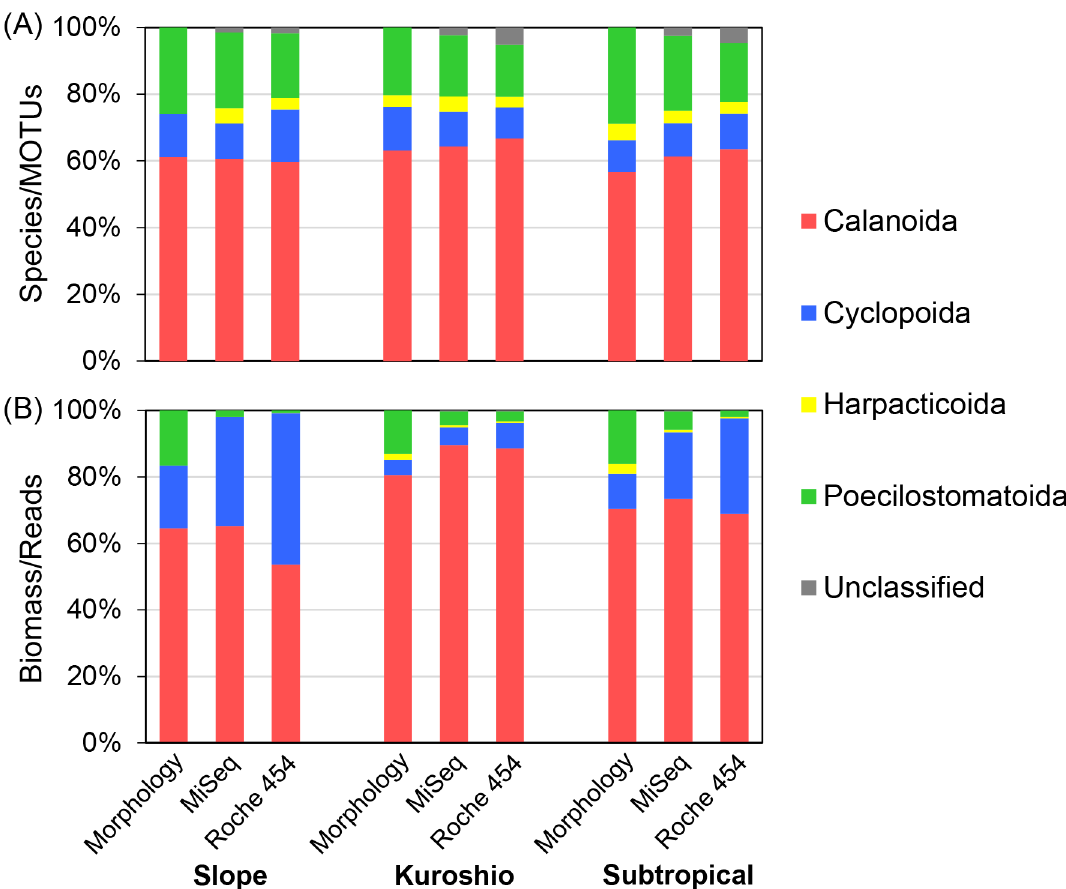
Fig 3. Order-level taxonomic compositions of copepods in field-collected samples between (A) species and MOTUs, and (B) biomass and sequence reads. Metagenetic analysesusing both Illumina MiSeq and Roche 454 data were performed at a 97% similarity